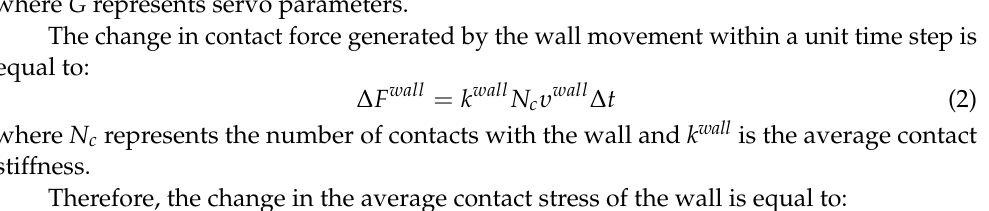
Figure 11. PFC3D model sample and parallel bonding model.